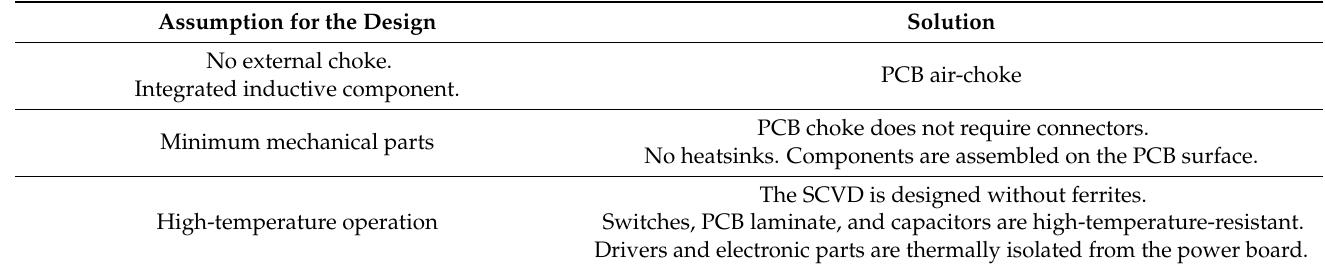
Table 1. Assumptions and concept of solution of the designed